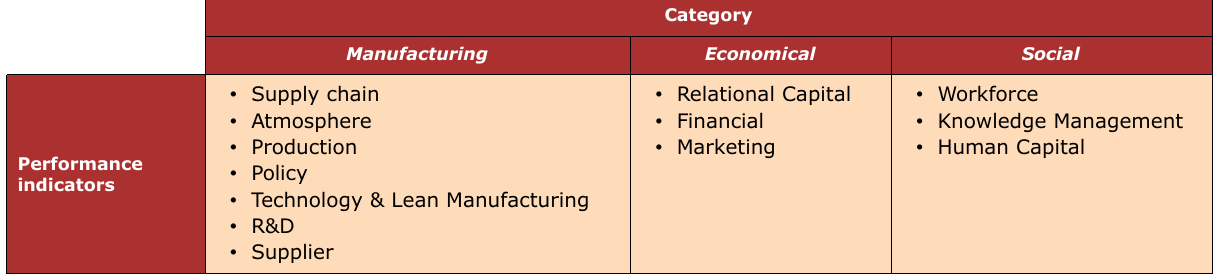
Table 2. Performance Indicators and